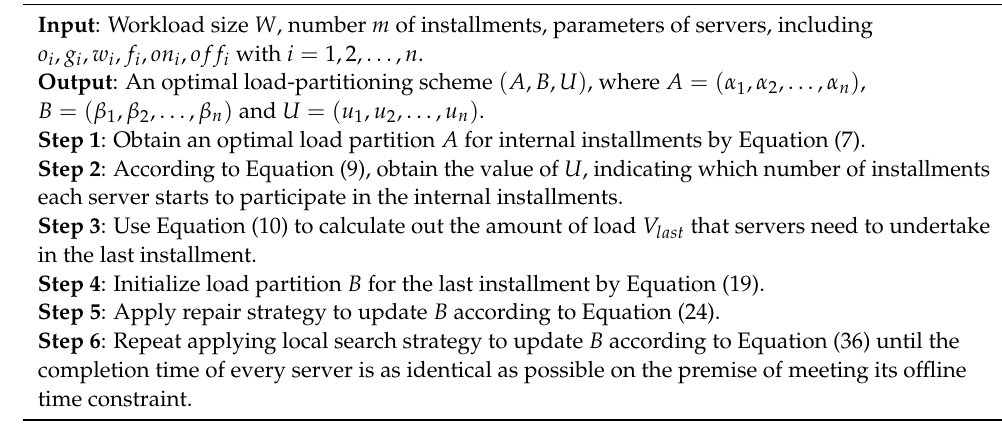
Algorithm 1. Heuristic Scheduling Algorithm